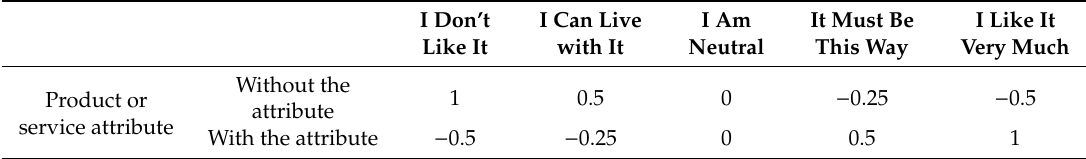
Table 2. Satisfaction scale of positive and negative